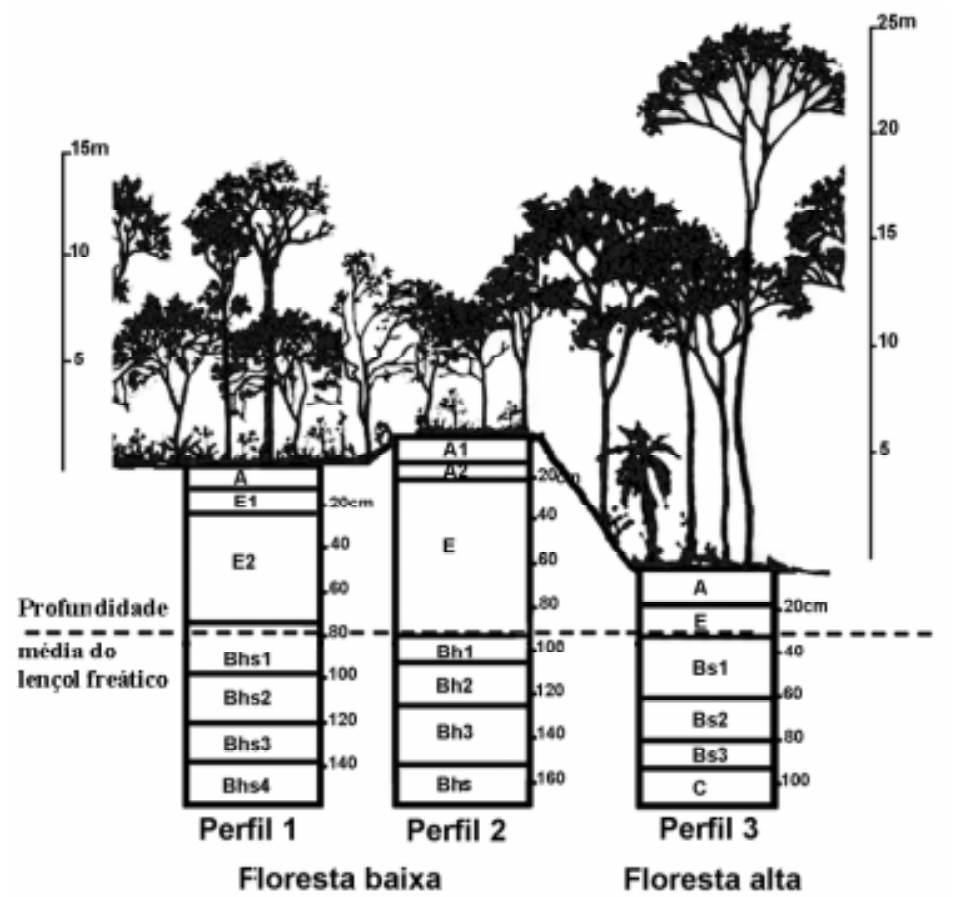
Figura 1. Desenho esquemático da localização dos perfis nas áreas